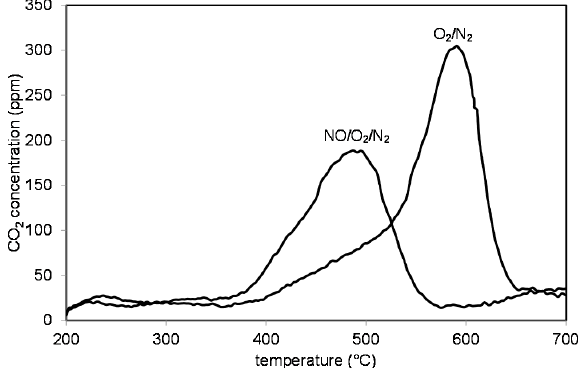
Figure 4. Soot oxidation carried out in a conventional flow reactor by monitoring evolution of CO 2 in O 2 /N 2 and NO/O 2 /N 2 atmosphere for a CeSrCu sample.